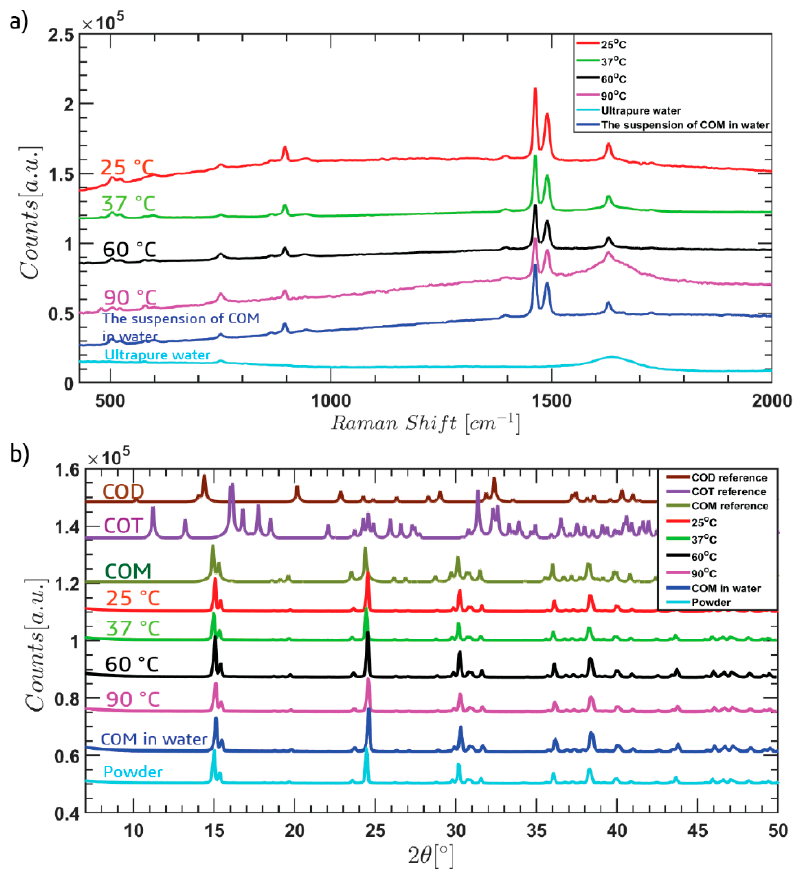
Figure 3. Characterization of suspended crystals in ultrapure water at different temperatures for ICP-OES experiments. ( a ) The results of six Raman measurements, 25 °C; red, 37 °C; green, 60 °C; black; 90 °C; magenta; the suspension of COM in water prior to experiment; blue, ultrapure water; cyan. ( b ) The results of nine XRD measurements. 25 °C; red, 37 °C; green, 60 °C; black; 90 °C; magenta, COM suspension filtered and dried at room temperature denoted as “COM in water”; blue, Powder (COM powder from supplier); cyan, COM reference; dark green, Calcium Oxalate Dihydrate (COD) reference; brown and Calcium Oxalate Trihydrate (COT) reference; purple.